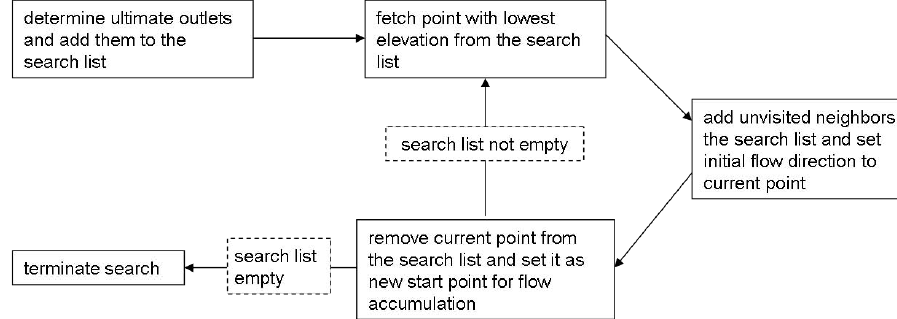
Fig. 1. Flowchart illustrating the least cost path search algorithm.